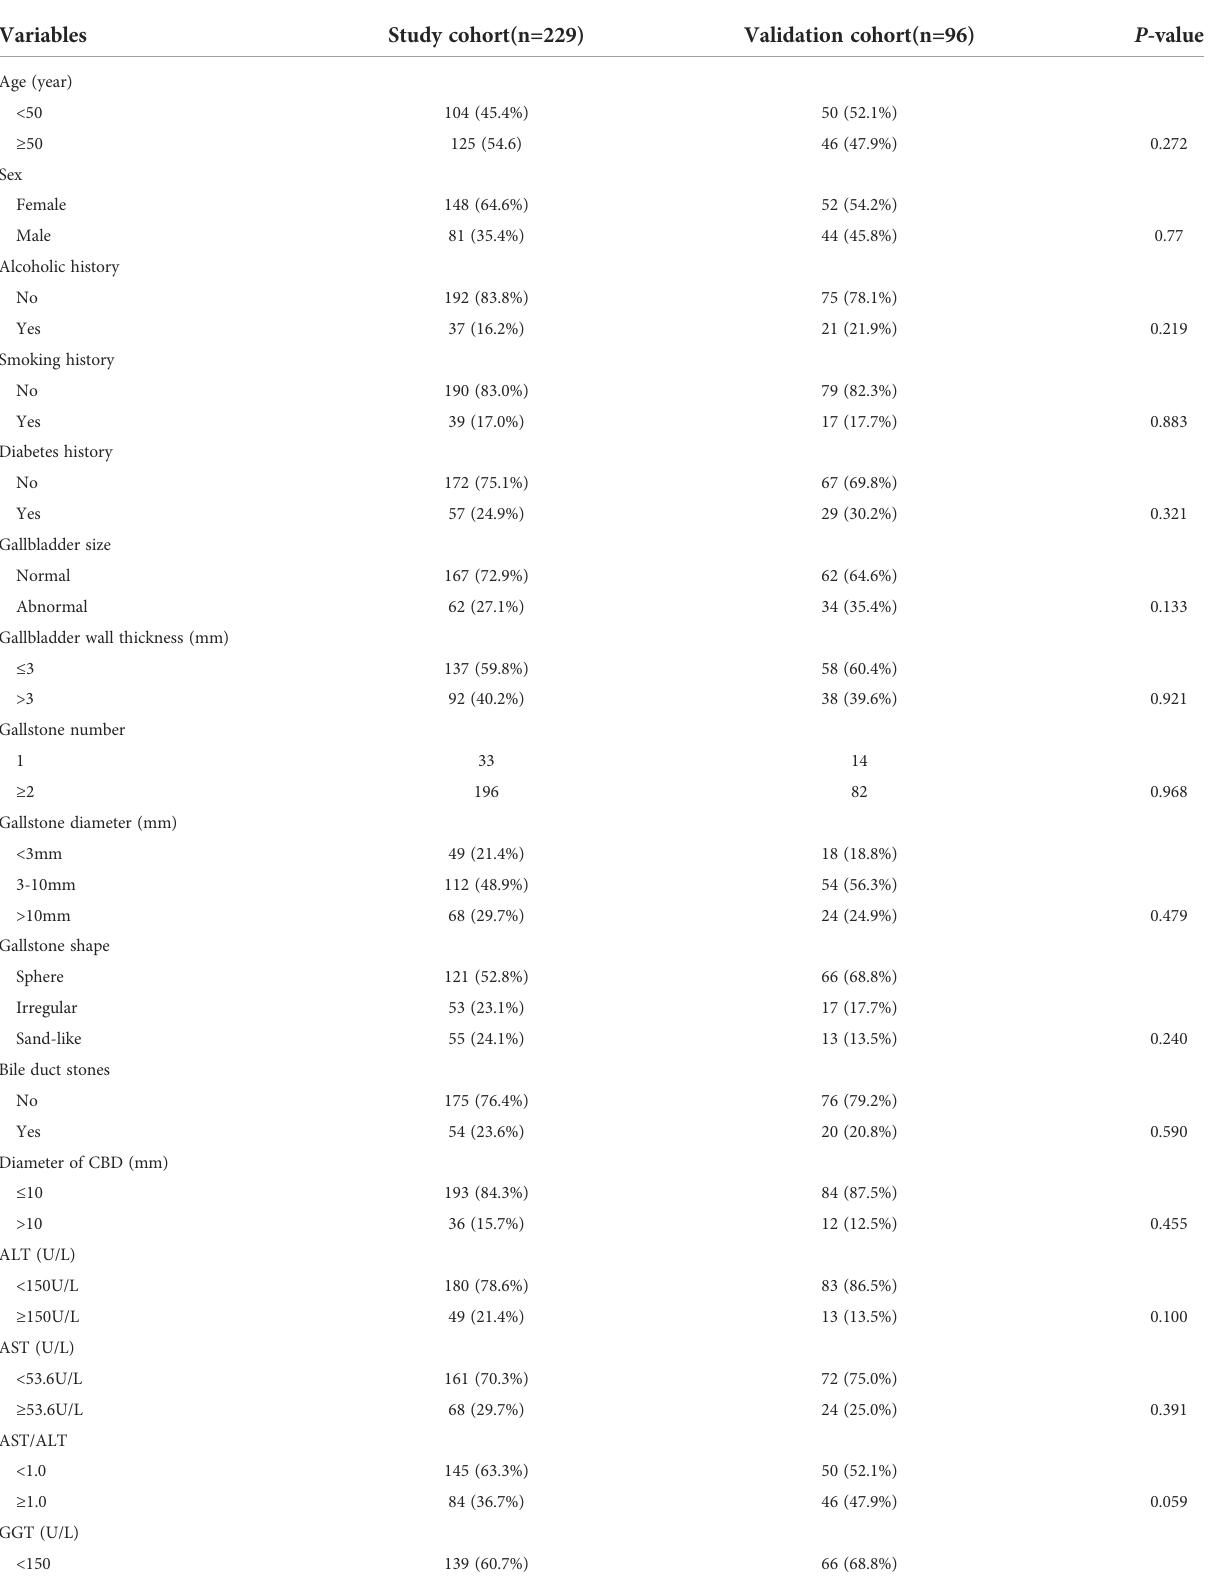
TABLE 1 Characteristics of patients in the study and validation